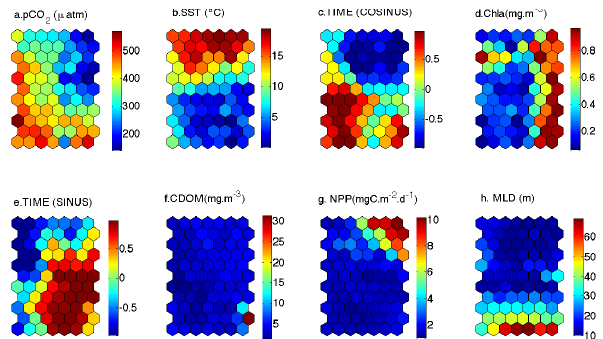
Figure 10. Distribution of each parameter in the neural map: (a) p CO 2 inµatm, (b) SST in ◦ C, (c) and (e) time cosine and sine respectively, (d) Chl a in mgm − 3 , (g) NPP in mgCm − 2 , and (h) MLD in